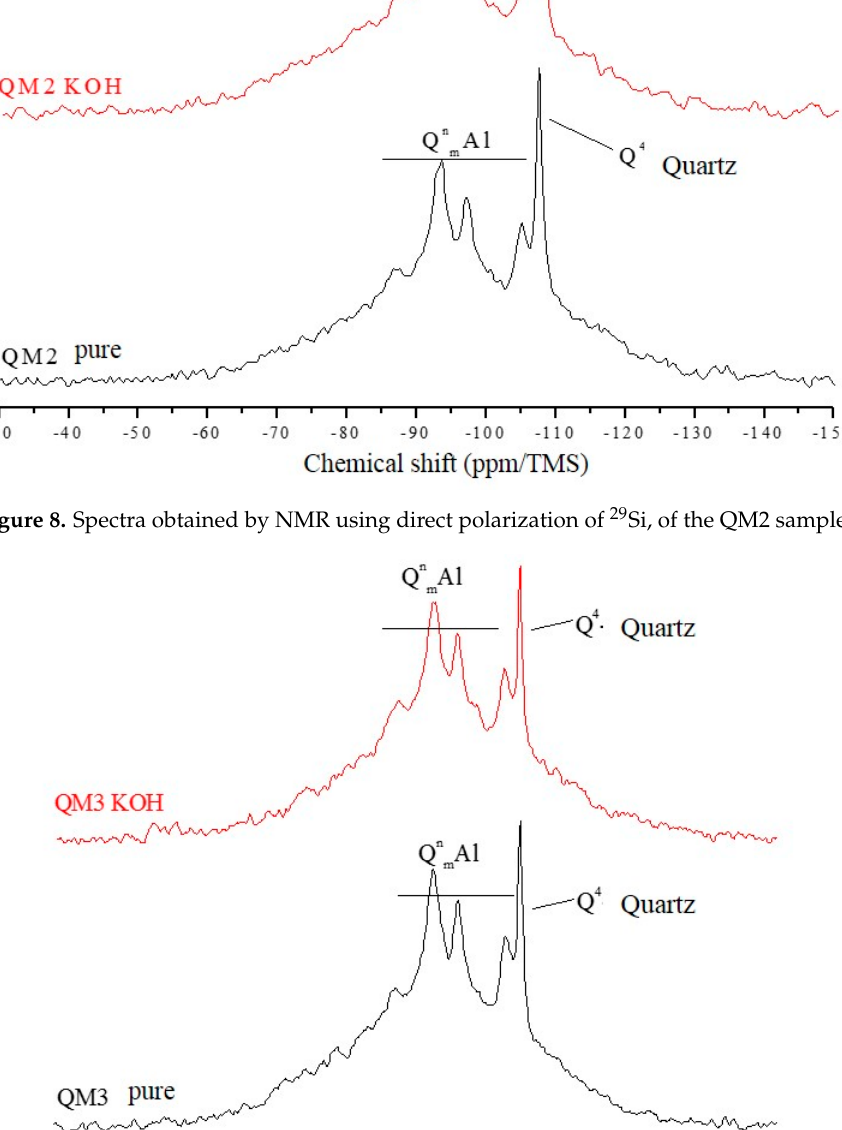
Figure 9. Spectra obtained by NMR, using direct polarization of the 29 Si, of sample